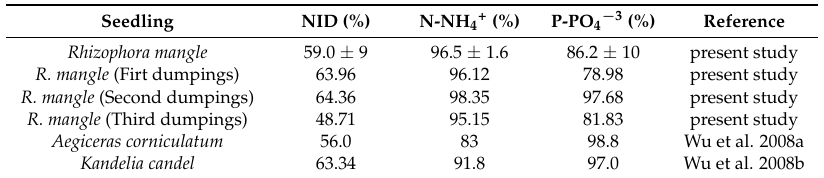
Table 7. Comparison of nutrient removal capacity between seedlings plants of three species under controlled